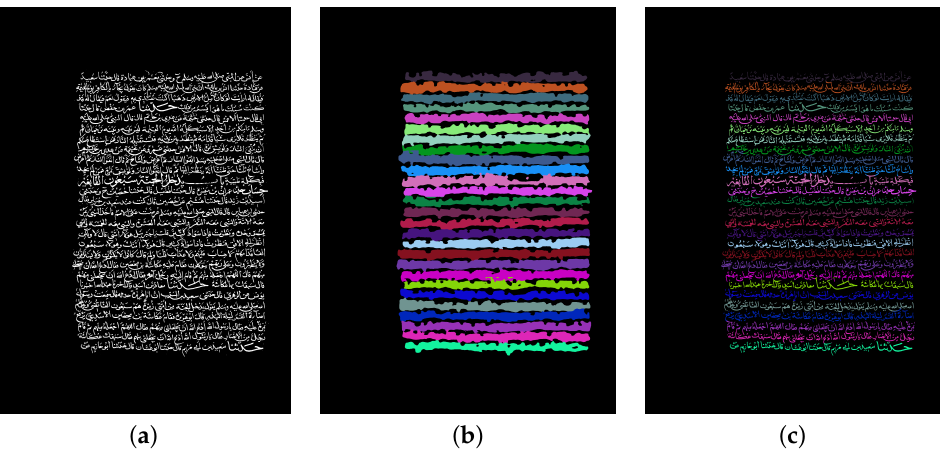
Figure 10. Mask R-CNN segmentation results: ( a ) an input page, ( b ) blobs prediction, and ( c ) pixel level prediction.